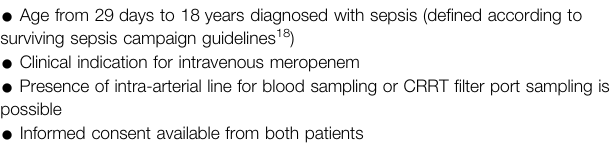
FIGURE 1 | Graphical overview of the structural pharmacokinetic model for meropenem. CL stands for clearance. CLCRRT stands for the